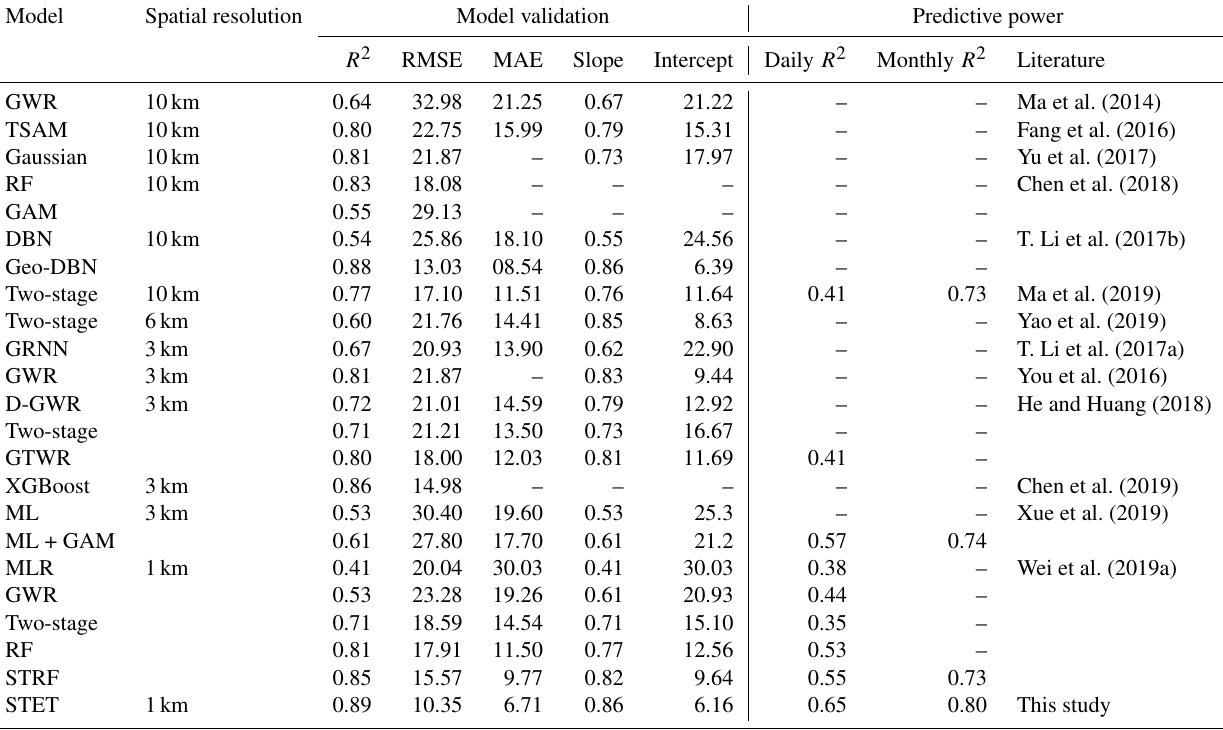
Table 2. Comparison between model performances of the enhanced STET model and other models from previous related studies focused on